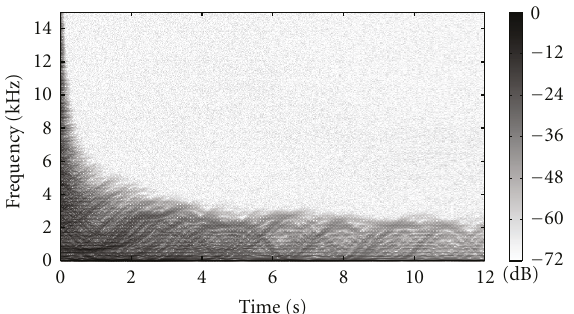
Figure 26: FBAM as an abstract physical model ( f x = 130Hz, f m : f x = 0 . 498, β = 0 . 9).